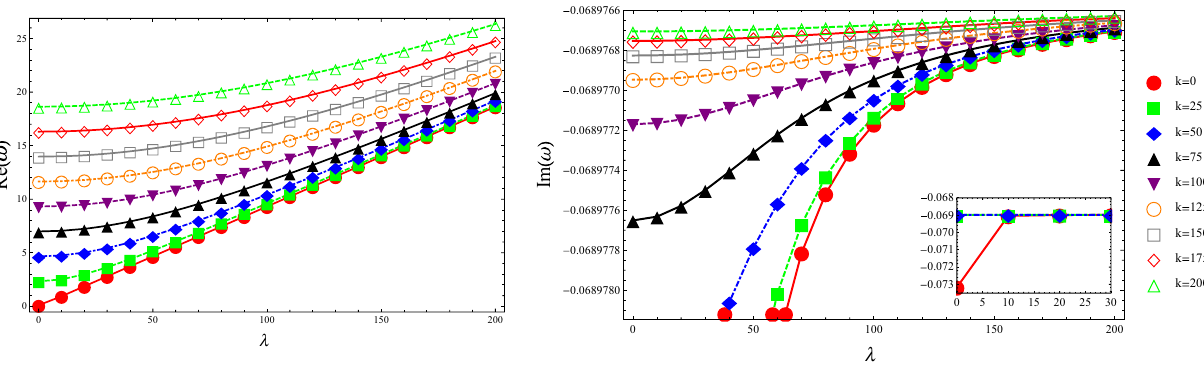
Fig. 6 The behaviour of QNMs at large λ, k for M = 1 ,α g = 1 ,(cid:14) = 0 ,α 2 m = − 0 . 04 ,γ = 0 . 4 , m s = 0 . 2. (Left) Plot of Re (ω) as a function of λ , (right) plot of Im (ω) as a function of λ , a small window shows the behaviour of k = 0 curve for small λ